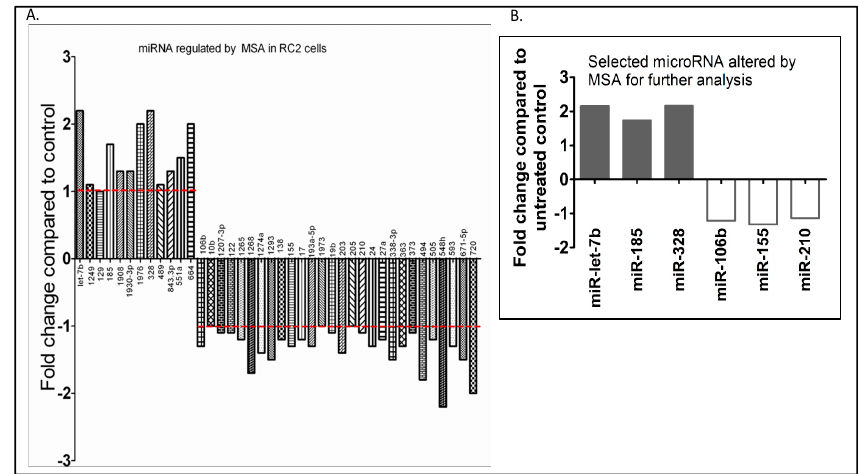
Figure 4. Oncogenic and tumor-suppressor micro RNAs (miRNAs) expressed in ccRCC are selenium targets. Effects of MSA on the expression levels of oncogenic and tumor-suppressor miRNAs altered in RC2 cells expressing HIF1 α : ( A ) microarray analysis of miRNAs regulated by the treatment of RC2 cells with 10.0 μ M MSA for 24 h, and ( B ) selected miRNAs shortlisted for further analysis. The data in Figure 5 indicate that the miRNAs that were significantly altered by MSA treatment of RC2 cells expressing HIF1 α and of 786.0 cells expressing HIF2 α were also altered in primary ccRCC biopsies.